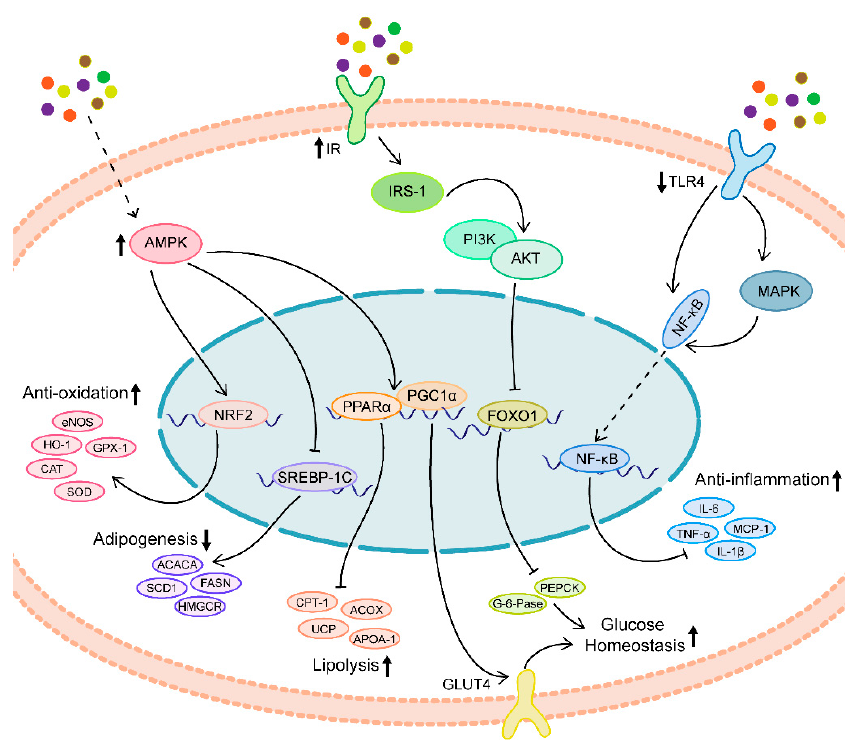
Figure 1. General overview of the underlying mechanism of natural polyphenols on MetS. Natural polyphenols improve the MetS mainly by increasing AMPK and IR/IRS1 activity and inactivating TLR4 pathway, which further induce the enhanced antioxidant and anti-inflammatory capacity.